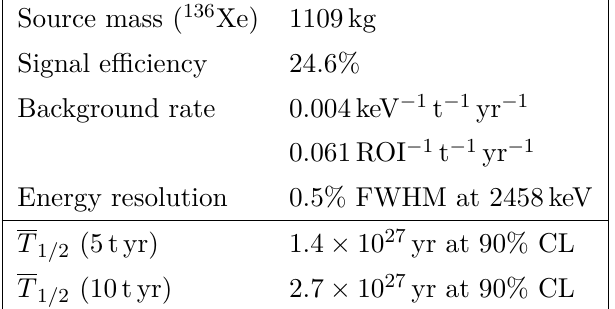
Table 4 . Key parameters for the calculation of the sensitivity of NEXT-1t and resulting mean lower limit (at 90% CL) on the 0 νββ -decay half-life for 5 and 10 tonne year of exposure.